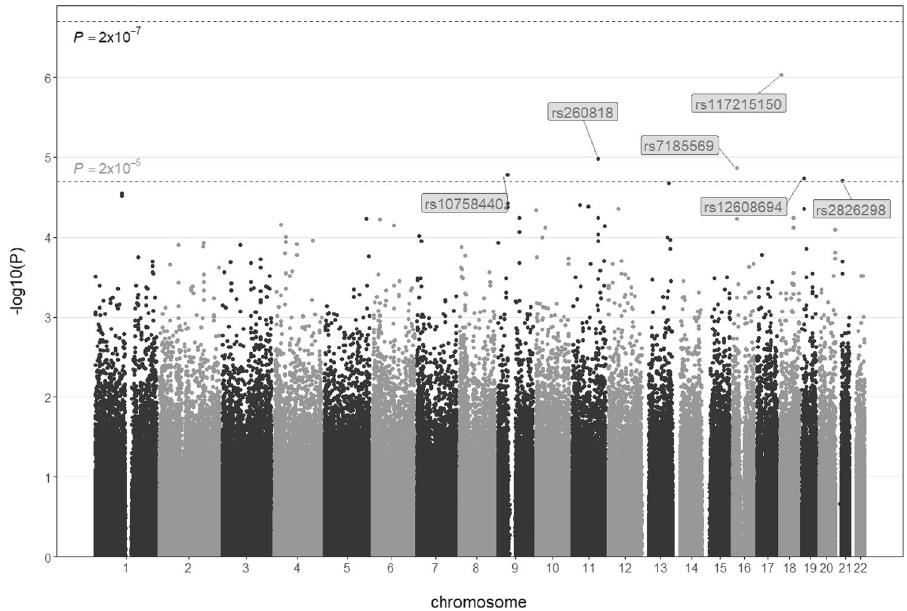
Figure 2. Manhattan plot of GWAS on the phenotype of normal vs. abnormal ECG. Bonferroni corrected threshold (2 × 10 –7 ) and less stringent candidate threshold (2 × 10 –5 ) respectively correspond to levels of 6.7 and 4.7 for − log 10 (P).